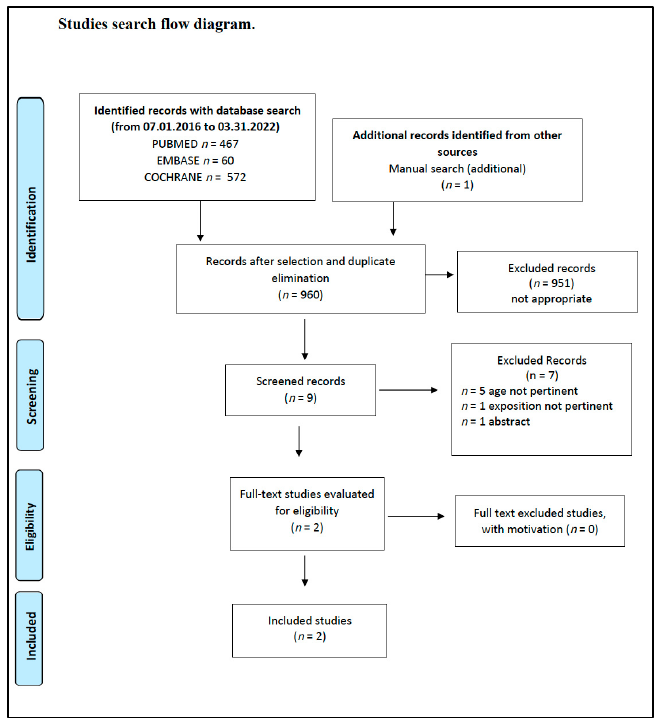
Figure 3. Vegetarian diets and different auxological development and/or growth. Flow diagram of the study